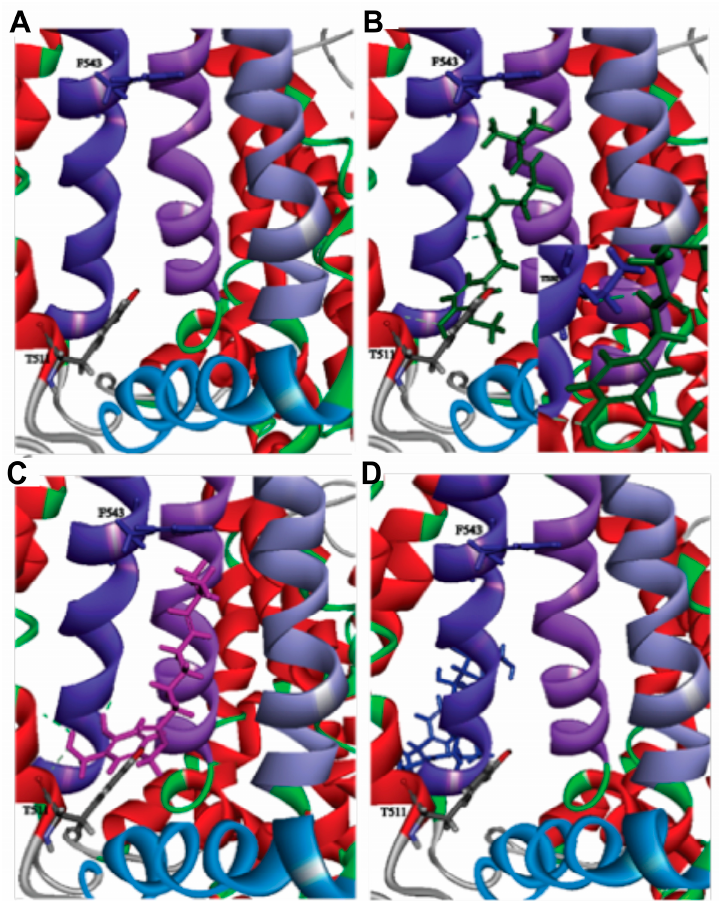
Figure 6. Binding of pungent and nonpungent analogs of CAP with TRPV1. A . Empty binding channel in TRPV1. Purple strands left, middle, and right represent the B: S4, D: S5, and D: S6 segments, respectively. The blue strand represents the B: S4-S5 linker. Amino acids F543 and T511 are represented in stick form for reference positions. B . CAP bound in the binding channel. The hydrogen bond between CAP and T550 is shown as a green dashed line. C and D. Capsiate and CAP- β - D gluco bound to TRPV1, respectively.